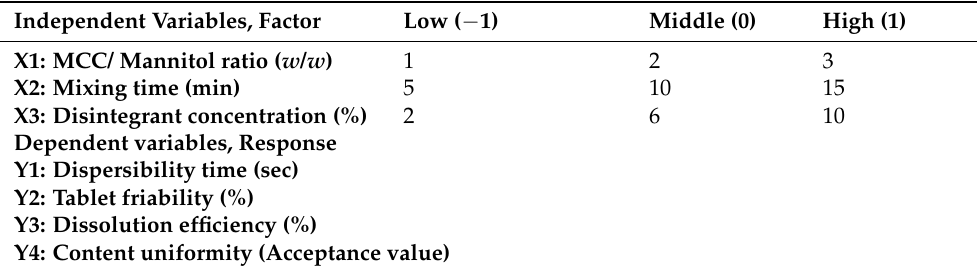
Table 8. Variables in Box–Behnken design for Lornoxicam DT.